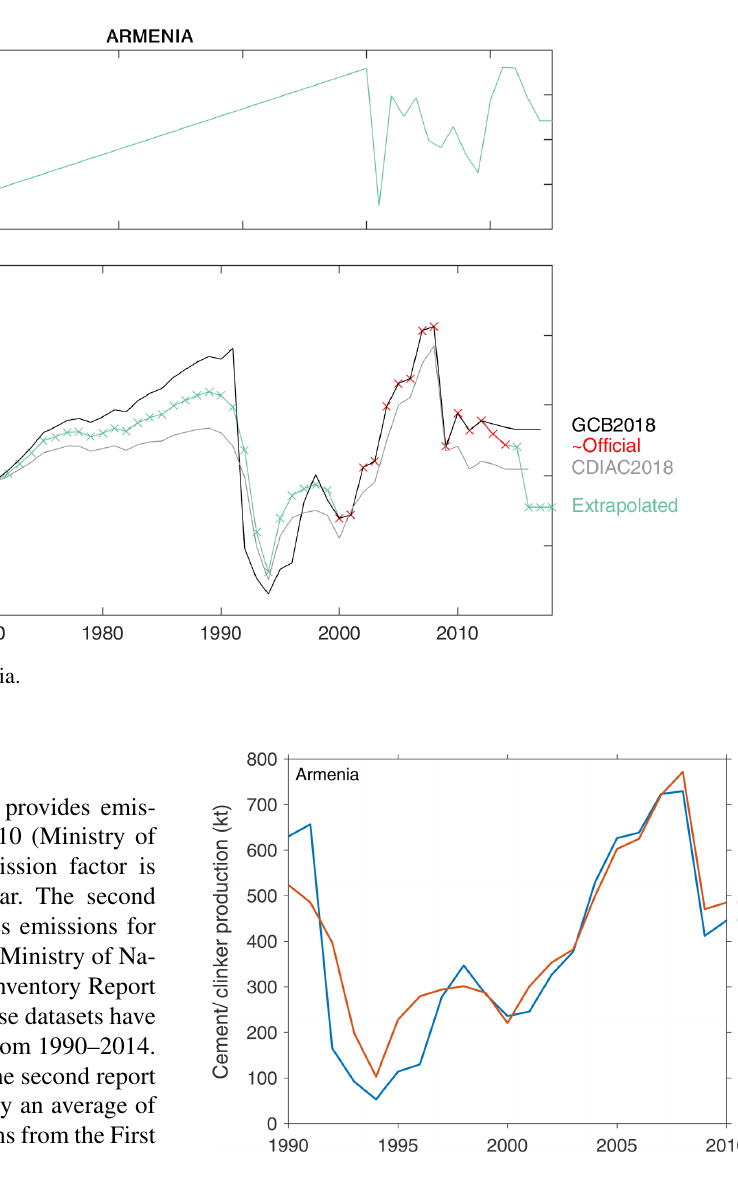
Figure C10. Clinker and cement production in Armenia,